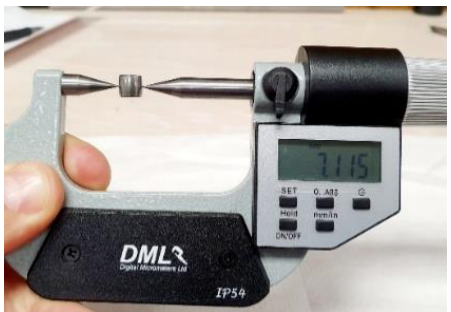
Figure 12. Quantification of the degradation generated in rolling elements .